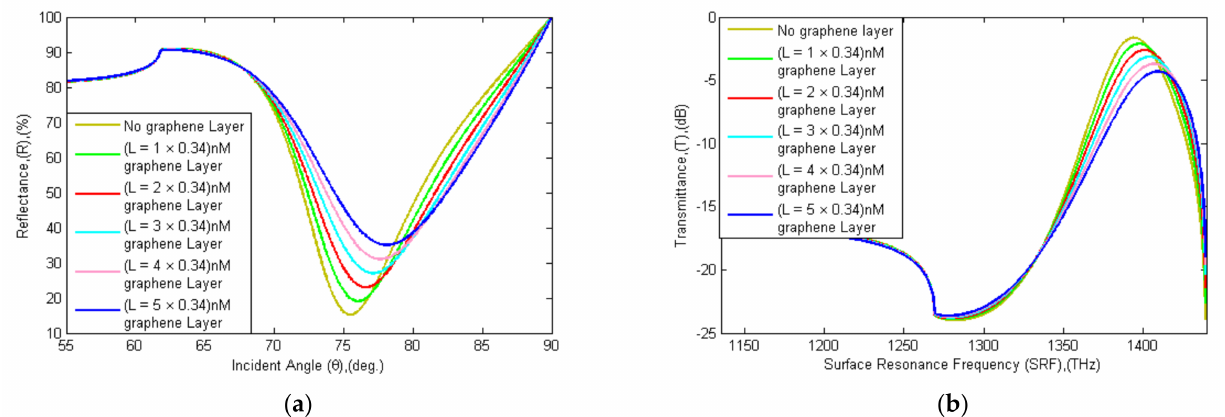
Figure 7. Schematic diagram of ( a ) SPR and ( b ) SPRF curve characteristics of Bk 7 /Au(50 nm)/PtSe 2 (2 nm)/Graphene (0.34 nm × L ) coated sensor reflectance and transmittance spectra with the thickness of the graphene layers ( L = 0, 1, . . . , 5) before adsorption of the analyte. Table 4. Comparison of change in R L , θ L , T L max , SRF L , sensitivity, FWHM, DA, FOM, and QF with the variation of SPR min freq the graphene layer (L) in the proposed SPR biosensor. Graphene Layer Thickness